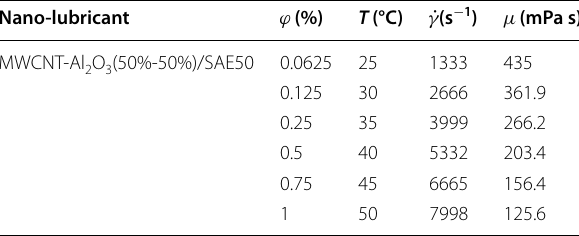
Table 3 Some data measured by a CAP2000